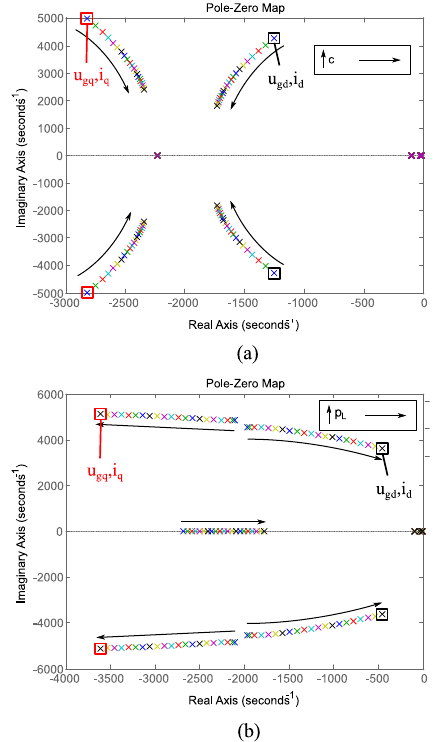
Figure 5. Model sensitivity to: ( a ) Point of common coupling (PCC) capacitance variation ( b ) Active load variation.